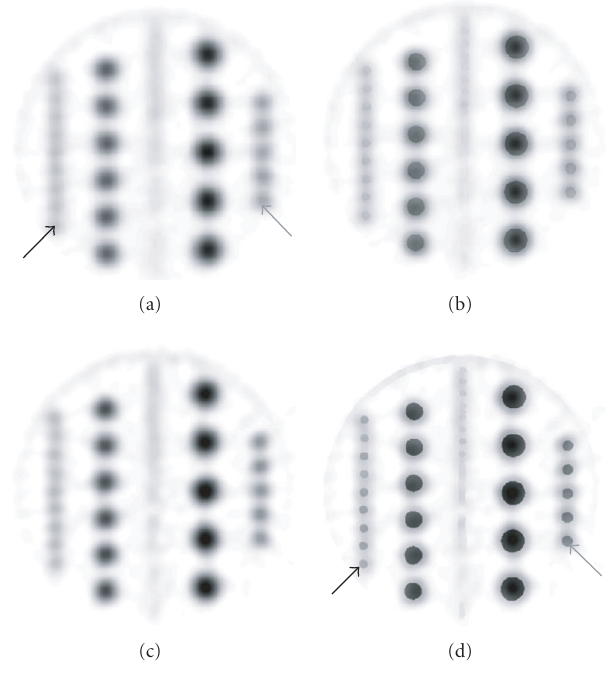
Figure 6: Transaxial PET images through the phantom disk us- ing 3D brain-mode acquisition. (a) Standard processing. The nine hotspots in the row (black arrow) along the left are 3 mm in diam- eter and the five largest hotspots are 8mm (gray arrow). (b) HCT result. (c) Super-resolution result. (d) Super-resolution/HCT result has the greatest contrast. The 3mm sources (black arrow) are more clearly resolved than in the standard image. The 8mm sources (gray arrow) show sharper edges than in the standard image.